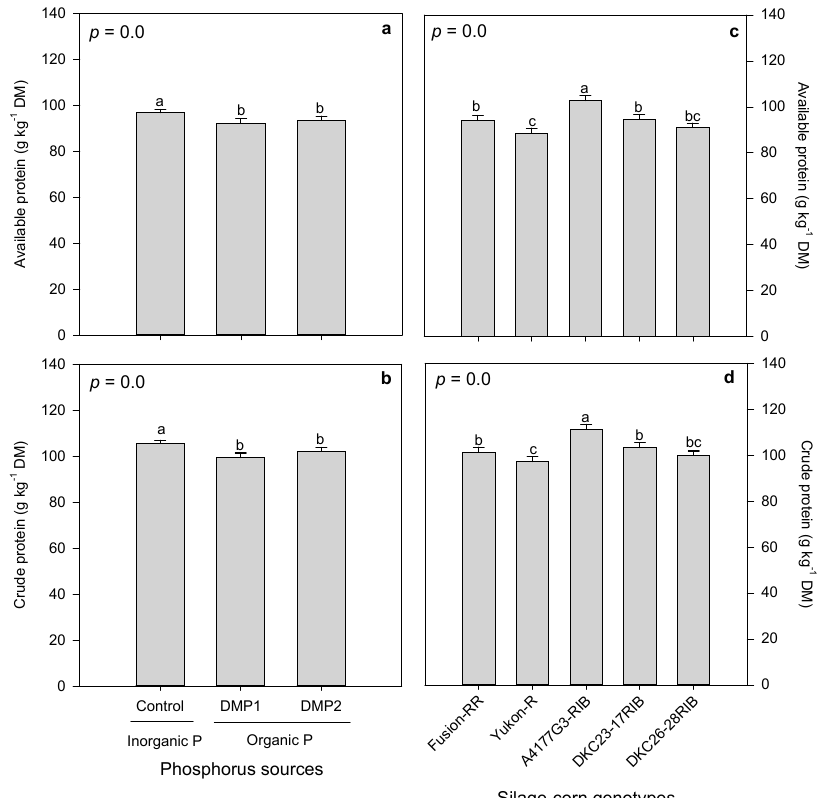
Figure 4. Effects of inorganic and organic phosphorus amendments on forage proteins: ( a ) available protein and ( b ) crude protein. Variation in available protein ( c ) and crude protein ( d ) among silage-corn genotypes. Each bar represents mean of three replications ± SE.